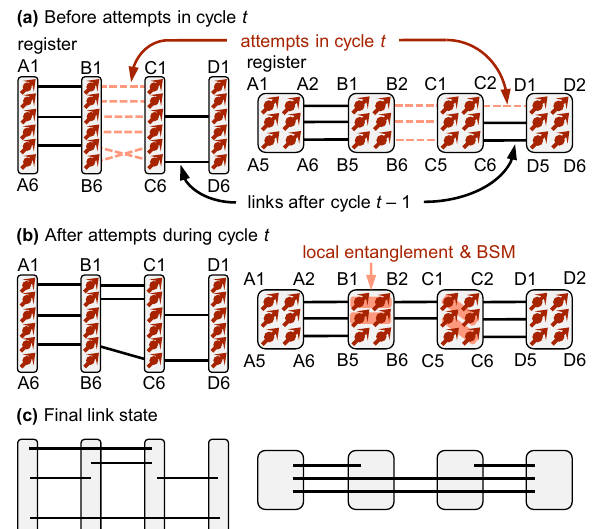
Fig. 6 Dynamics of repeater chains. Four repeater nodes in each chain are shown for both the standard repeater chain (left panels) and the router chain (right panels). Both chains have the same number of successful entanglement links. Registers in each node are labeled from A1 to D6. a State of the chain before the entanglement attempts during some clock cycle t . The entanglement attempts to be made in clock cycle t are shown as dashed lines. b State of the chain after the entanglement attempts during clock cycle t , but before Bell state measurements are performed. Bell state measure- ments in the router chain are performed according to the fi rst-in- fi rst-out strategy. c Link state after Bell state measurements during clock cycle t . The standard repeater chain has one long link that spans all four nodes, but the router chain has two long links. The standard repeater chain is unable to connect the shorter links that are available to form long